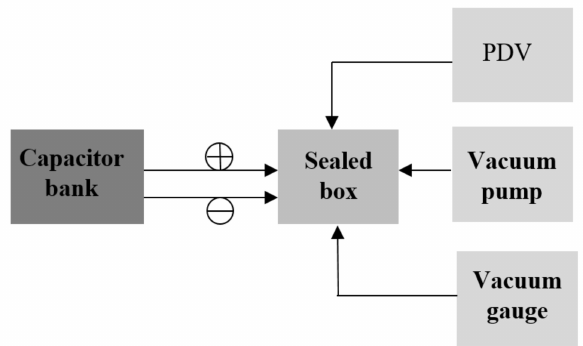
Figure 2. The magnetic-pulse-forming system for the forming of bipolar plates: The experimental work was carried on in the sealed box. Photon Doppler Velocimetry (PDV) was used to measure the velocity. The capacitor bank provided the energy.